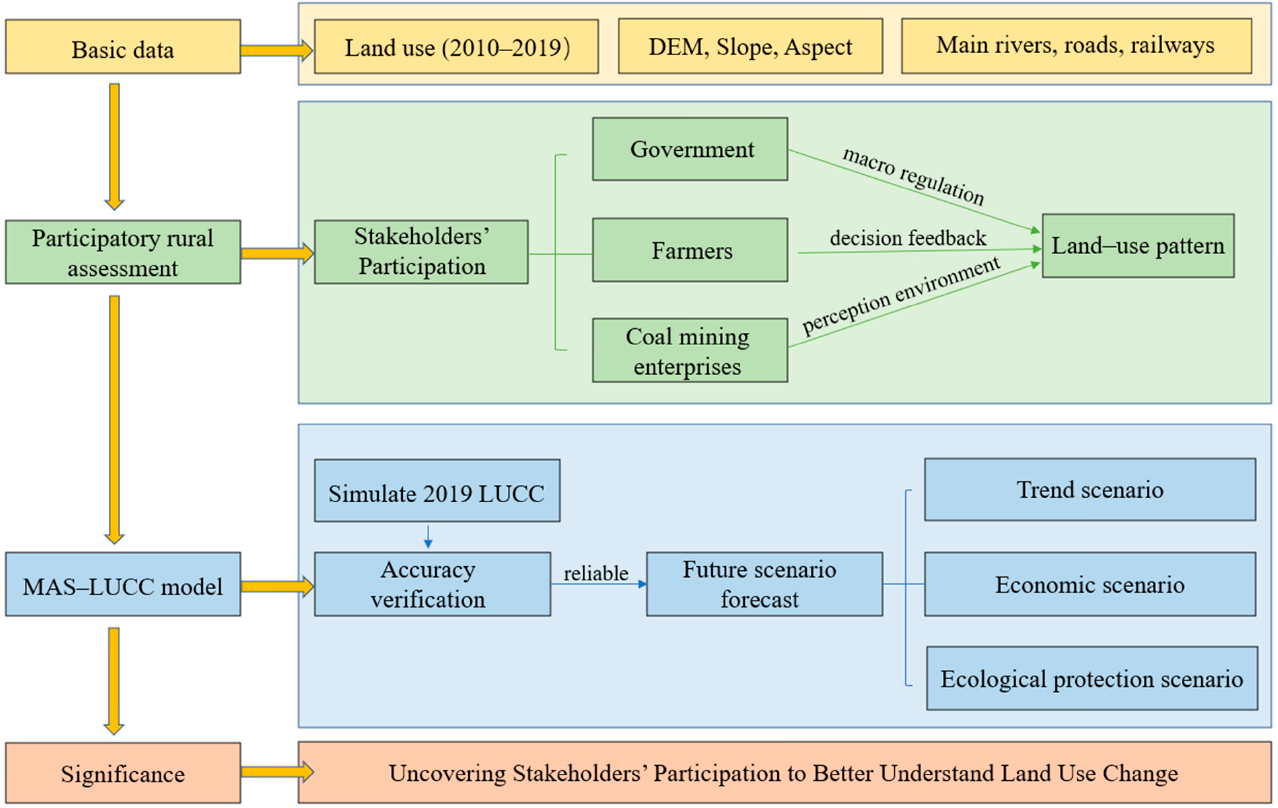
Figure 2. The framework of this